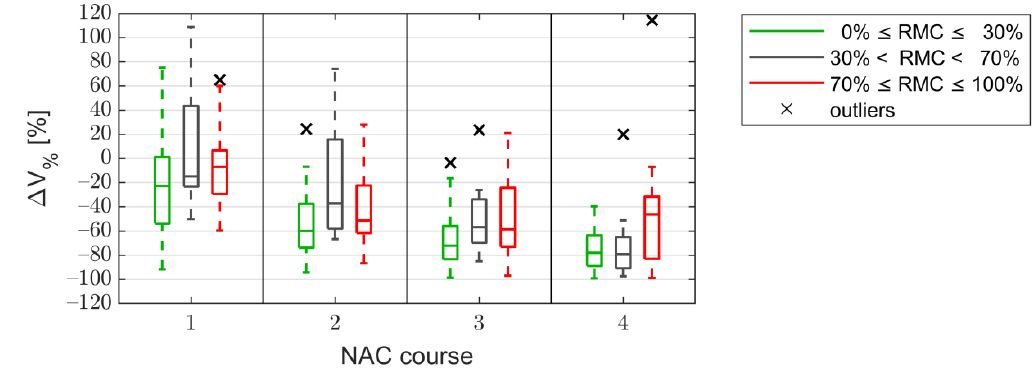
Figure 5. Statistics of the volume change ∆ V % after subsequent courses of neoadjuvant chemotherapy (NAC). The tumors are divided into responding (RMC ≤ 30%), partially-responding (30% < RMC < 70%), and non-responding (RMC ≥ 70%). (RMC—Residual Malignant Cell).